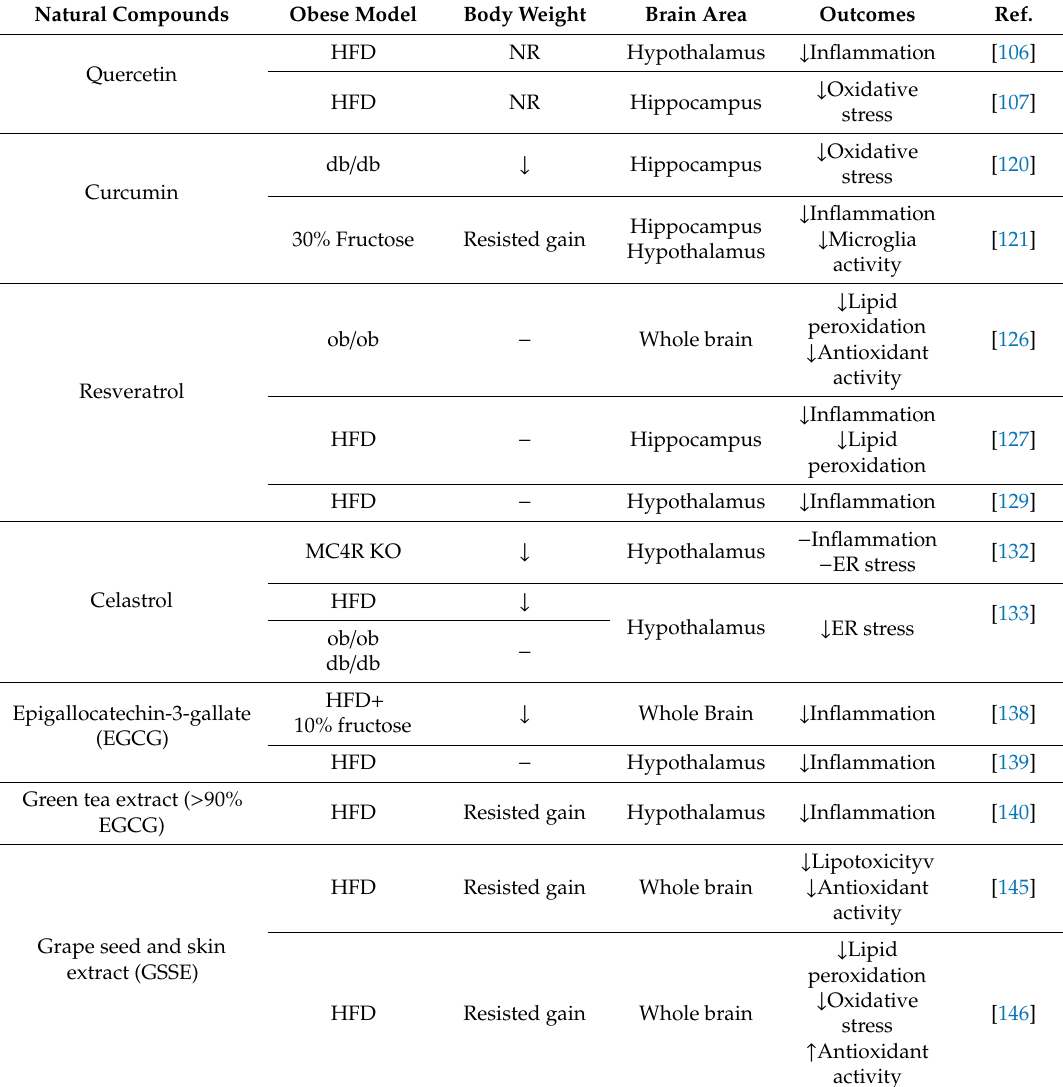
Table 1. E ff ects of natural compounds on energy balance associated with CNS regional oxidative stress and